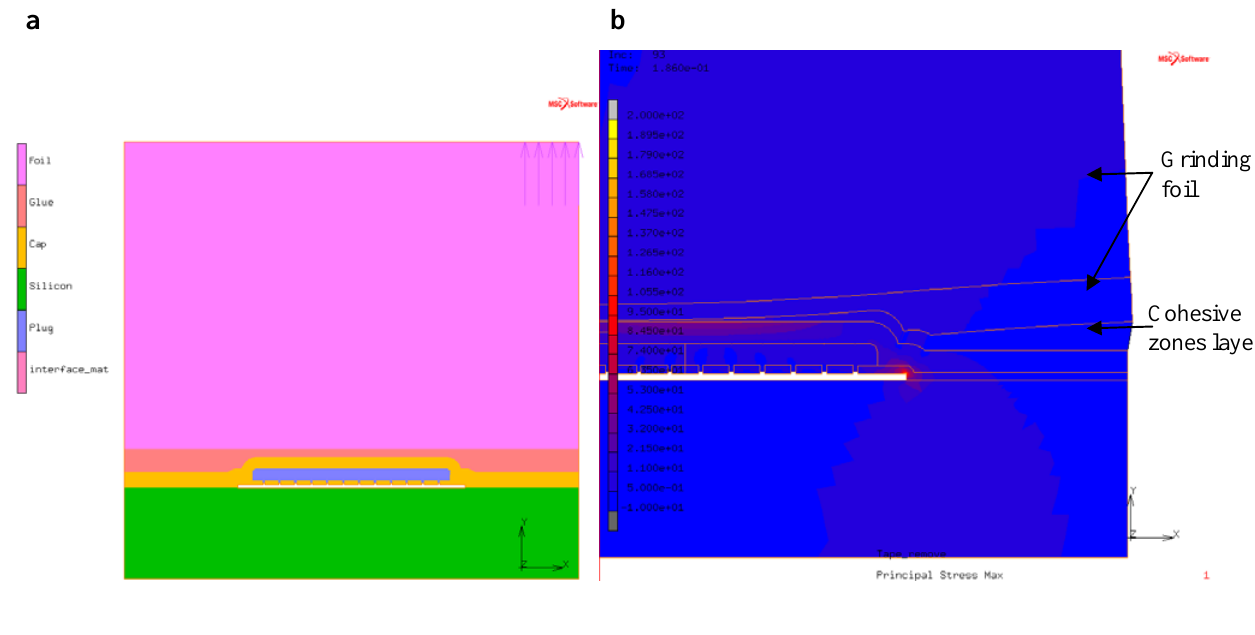
Figure 8. (a) Tape removal model; (b) Principal stressed caused by tape removal